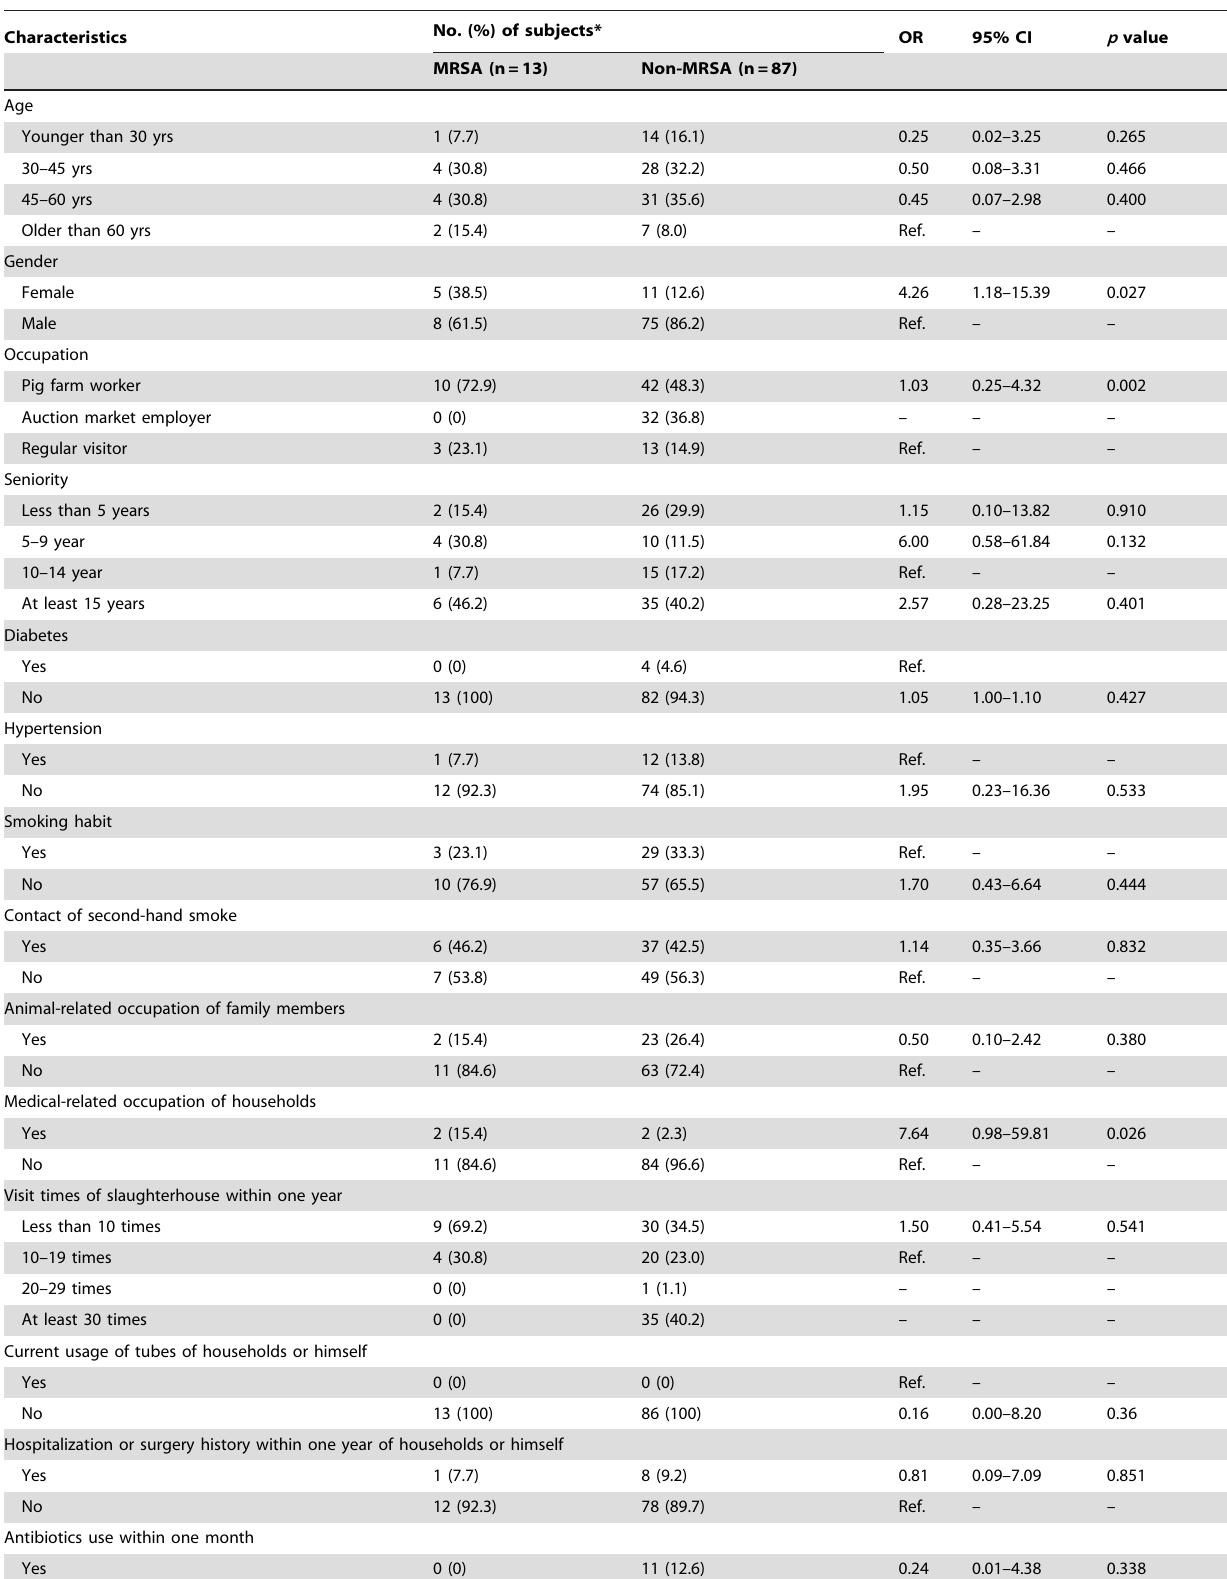
Table 3. MRSA prevalence among related workers in aspect of demographic and clinical data.